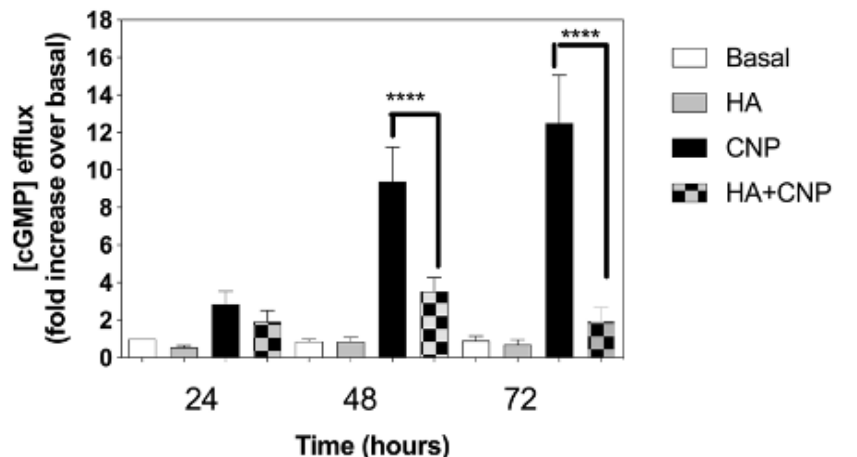
Figure 5. Effects of hyperammonaemia on CNP-stimulated cGMP efflux rat C6 glioma cells. C6 cells were treated in media containing 1% ( v / v ) FCS and either 0 or 10 mM NH 4 Cl, (HA) in the absence or presence of 100 nM CNP, for up to 72 h. Spent media were collected at the indicated time points and analysed for cGMP content. Data shown are means ± SEM of 6 to 8 independent experiments, each performed in triplicate, and normalized to basal at each time point. **** p < 0.0001, significantly different to control response to CNP.